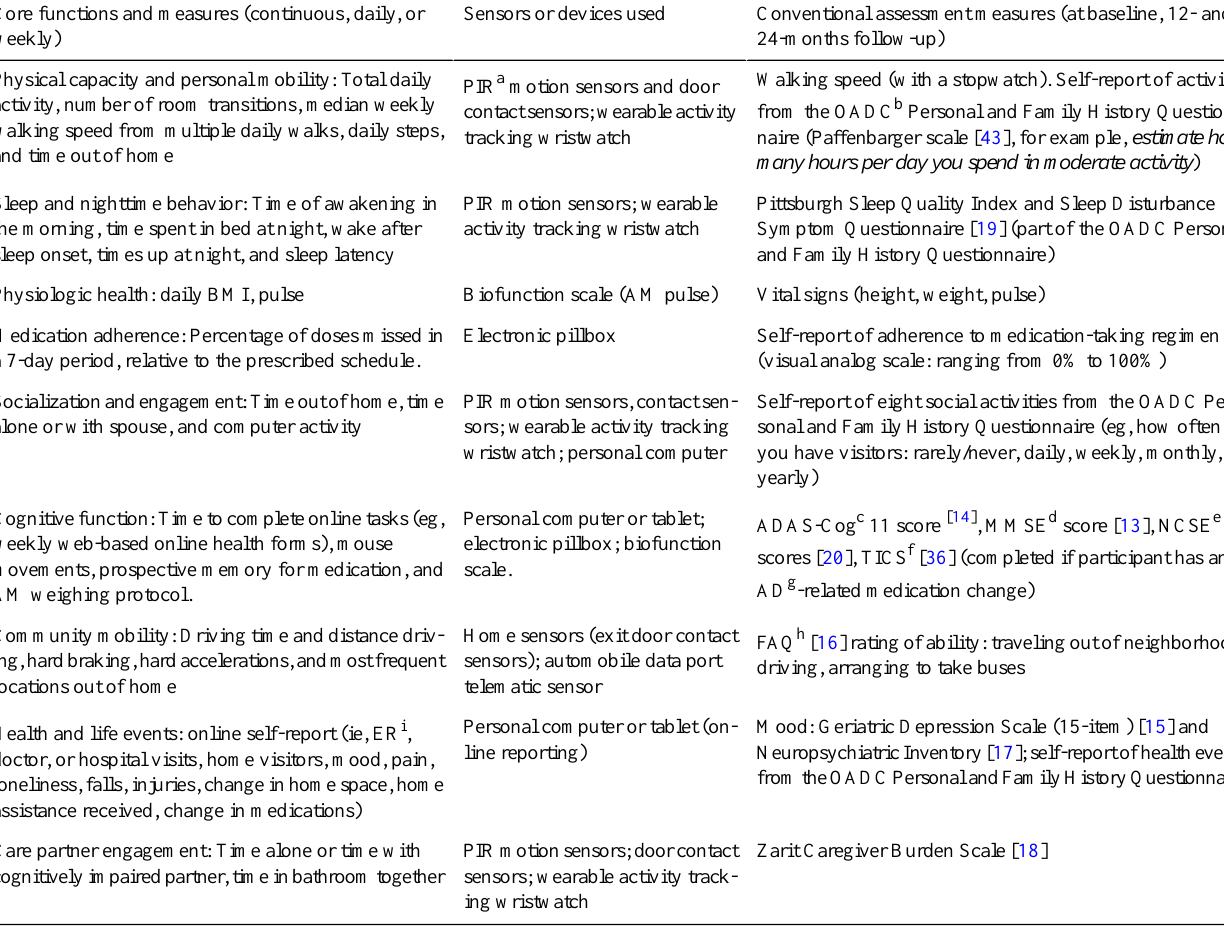
Table 2. Core functions and measures collected and types of sensors used to collect data. Metrics may be event driven (eg, medication taking) or unscheduled (eg, minutes to days of total